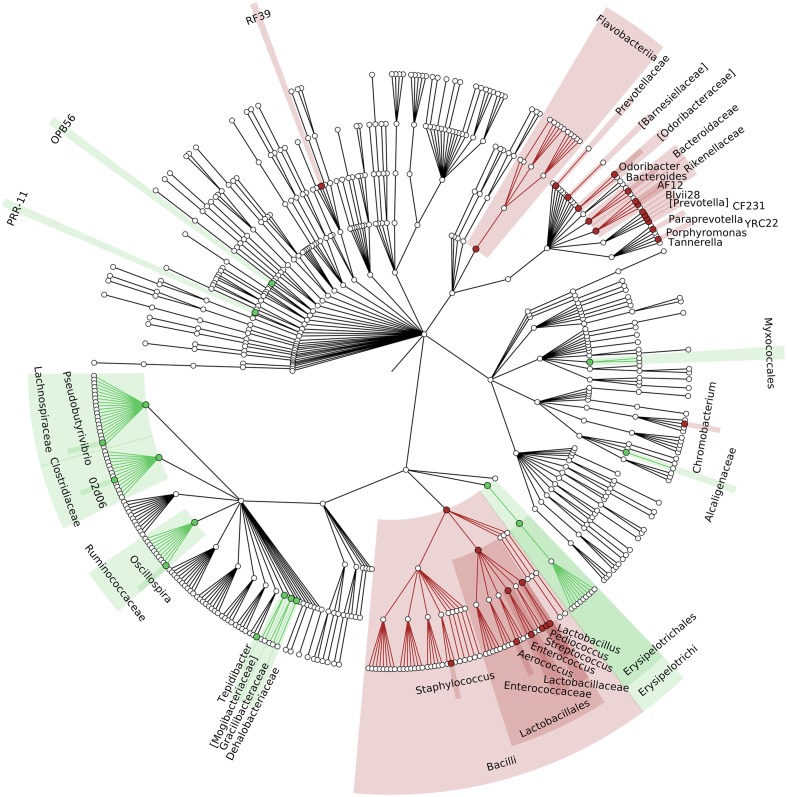
Cladogram illustrating the distribution of taxa with differential abundance between cecal contents (CCs) and feces, according to 16S-MG data. Each dot represents an identified taxon, with taxa higher in CCs colored in green, and those higher in feces in brown.